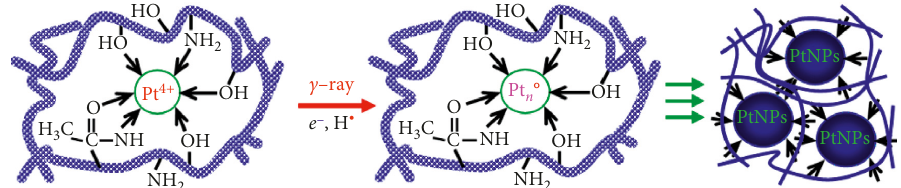
Figure 5: Schematic diagram of chitosan capped PtNPs synthesized by the gamma Co-60 ray